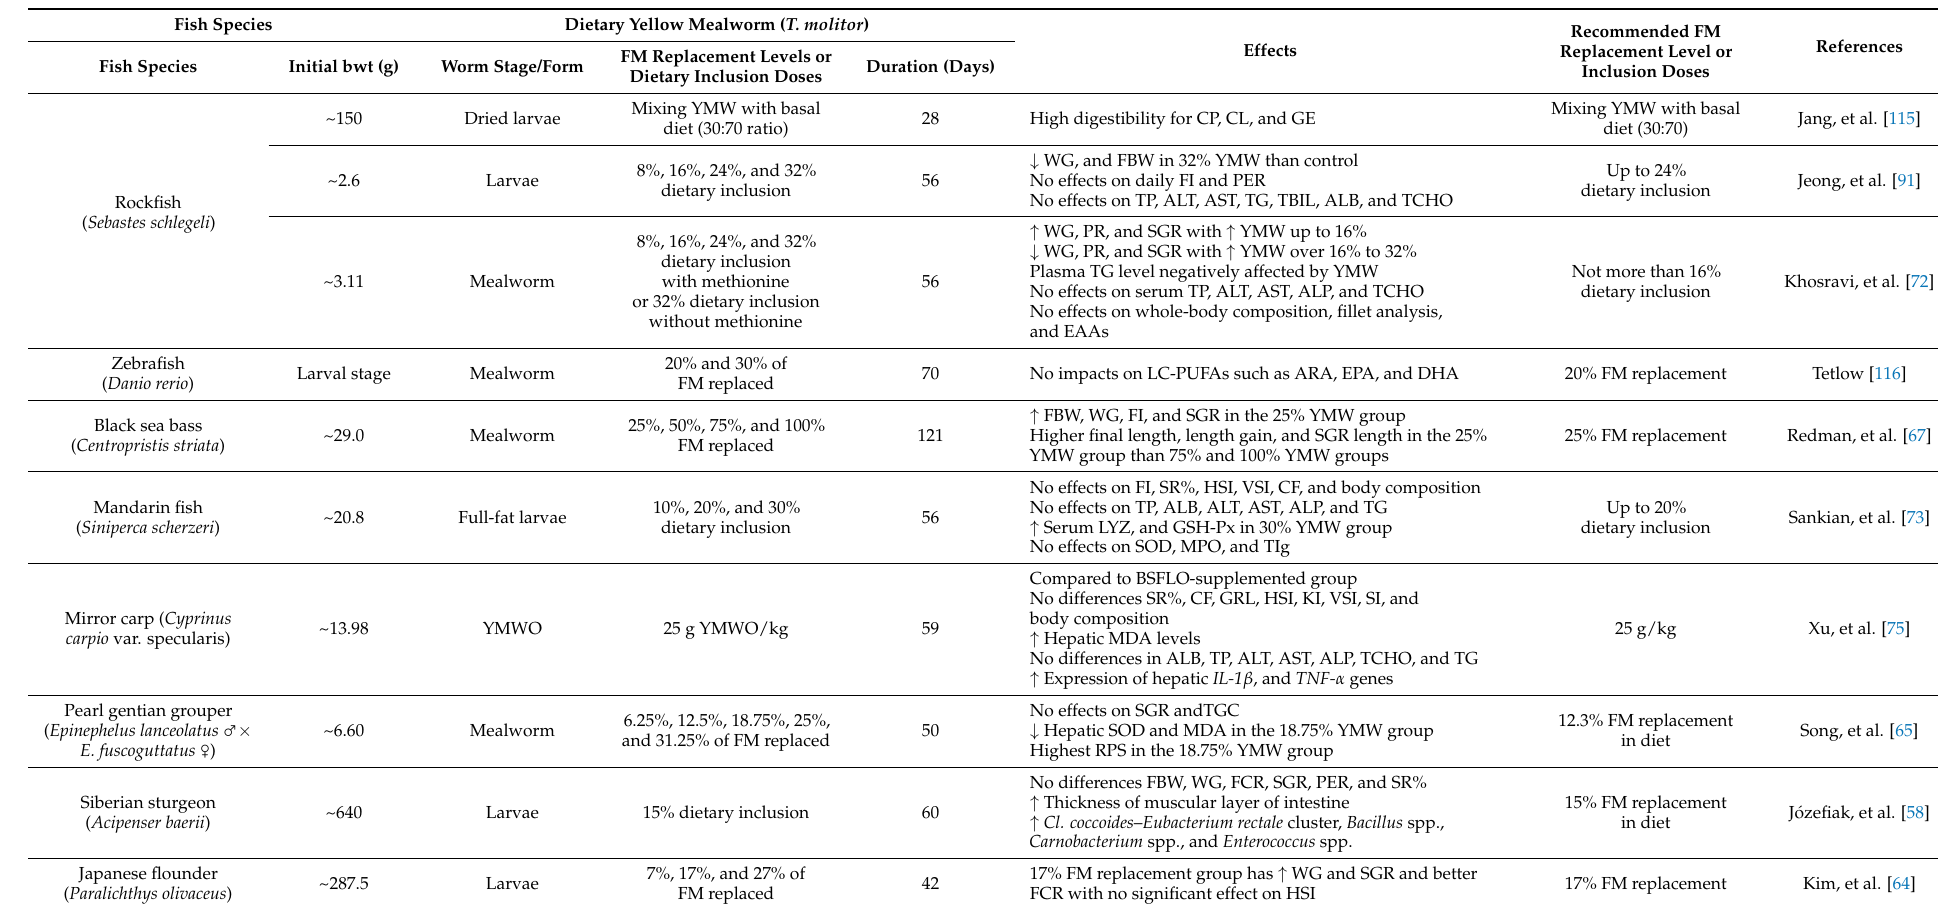
Table 7. Application and effects of using the yellow mealworm ( Tenebrio molitor ) in the diets of several other fish